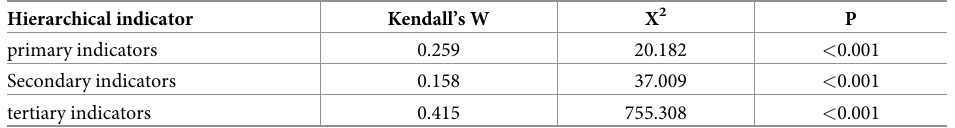
Table 3. The result of expert suggestions’ coordination degree(the second